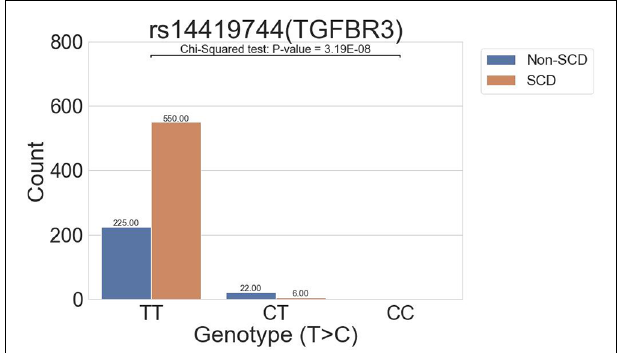
FIGURE 2 | The distribution of the rs14419744 (TGFBR3) variant allele frequency.